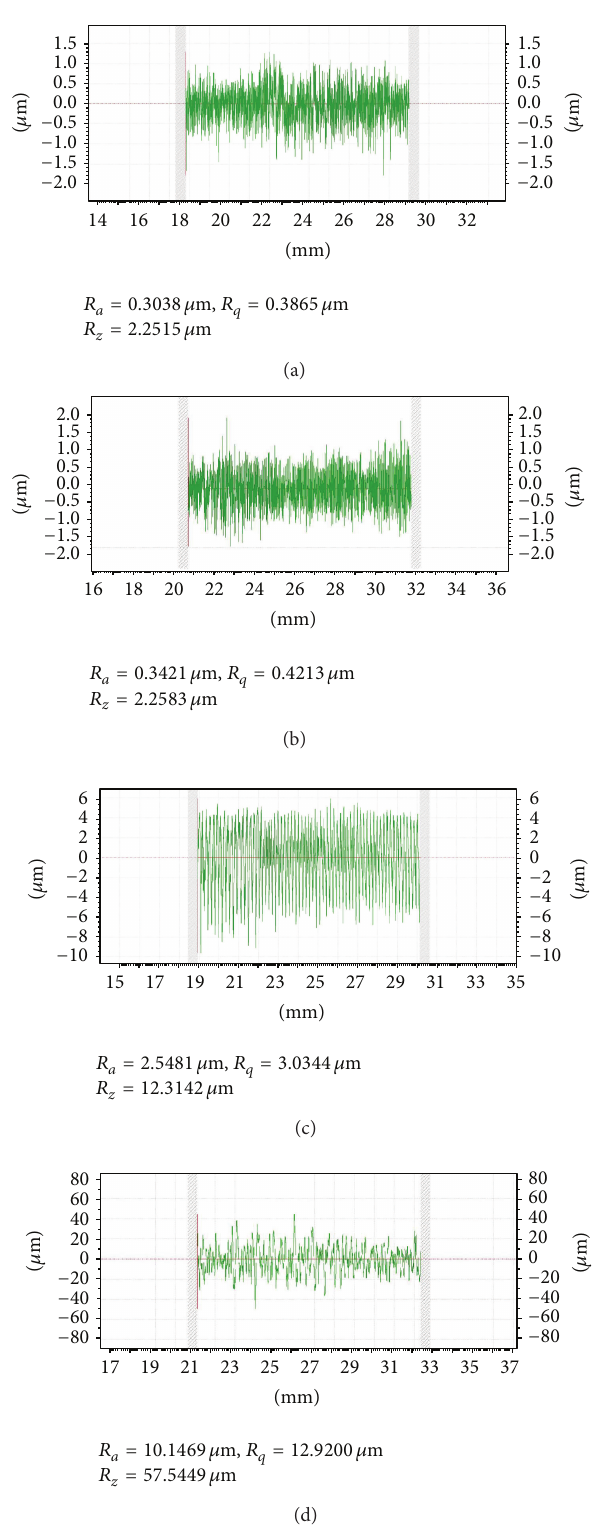
Figure 1: (a) Surface roughness parameters of as-sintered zirconia surface. (b) Surface roughness parameters of selective infiltration etched zirconia surface. (c) Surface roughness parameters of LPPA zirconia surface. (d) Surface roughness parameters of fusion sput- tered zirconia surface.